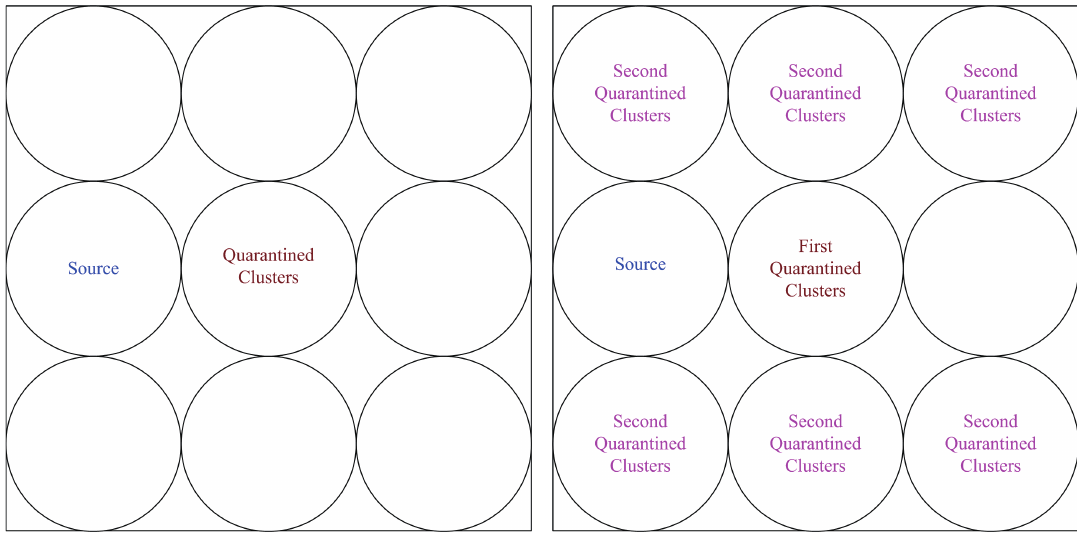
Figure 9. The locations of quarantined clusters given the location of source group 2; one cluster quarantined (left), two clusters quarantined with possible locations of the second quarantined cluster